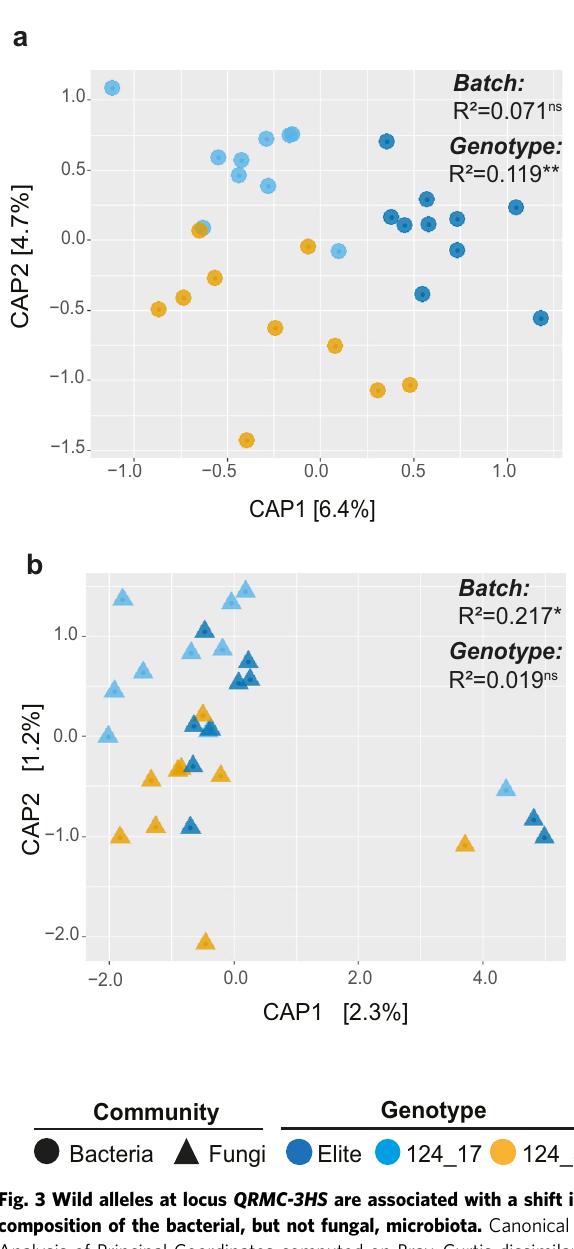
Fig. 3 Wild alleles at locus QRMC-3HS are associated with a shift in the composition of the bacterial, but not fungal, microbiota. Canonical matrix of a bacterial or b fungal ASVs ’ abundances. Sample type is depicted in the bottom part of the fi gure. The number in the plots show the proportion of variance ( R 2 ) explained by the factors ‘ Batch ’ and ‘ Genotype ’ , respectively. Asterisks associated to the R 2 value denote its signi fi cance, ns not signi fi cant. a P -value ‘ Batch ’ = 0.278, F = 1.10; P -value ‘ Genotype ’ = 0.005, F = 1.84; Adonis test 5000 permutations. b P -value ‘ test 5000 permutations. Source data are provided as a Source data fi